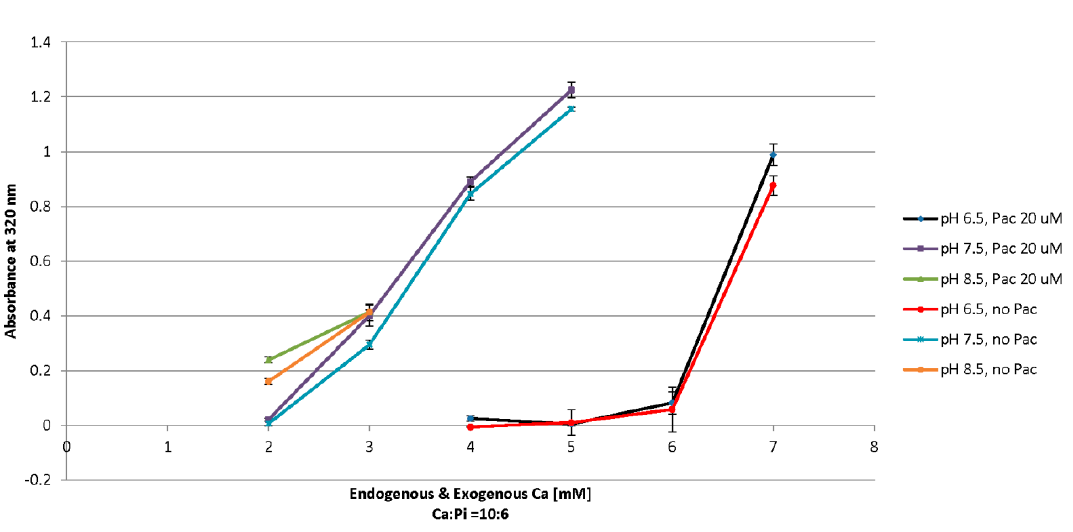
Figure 5. Apatite was formed in bicarbonated medium by mixing with it calcium and Pi at a Ca:Pi ratio of 10: 6 with or without 20 uM Pac at pH 6.5, 7.5, and 8.5. After 30 min of incubation at 37 °C turbidity was measured at 320 nm against fresh media as a blank. Values for apatite were calculated by deducting values for free drug at different concentration. All experiments were perfomed in duplicate and the data represents the mean ± SD.